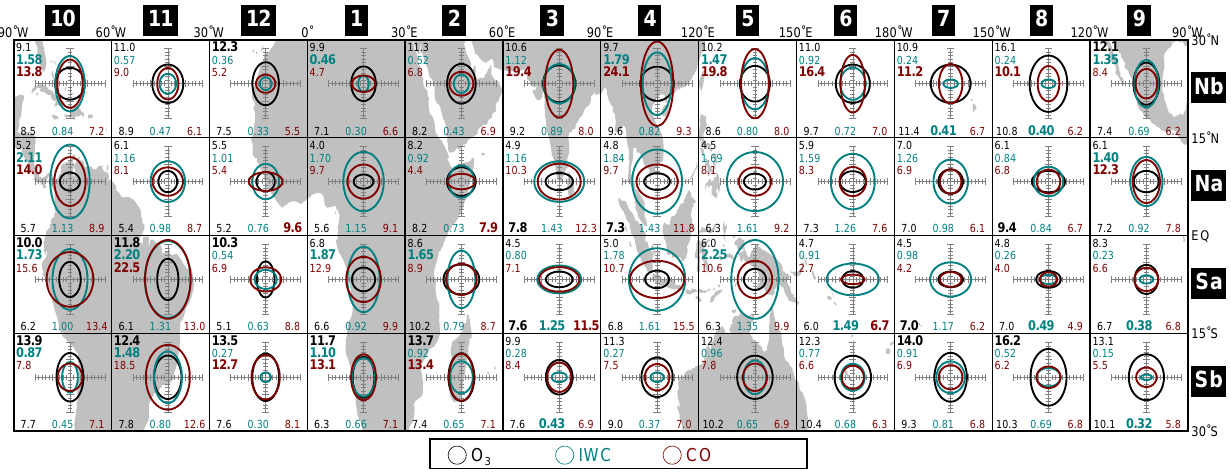
Fig. 8. Map summarizing the S (height of each ellipse) and V (width of each ellipse) statistics for O 3 (black), IWC (cyan) and CO (red). The ‘crosshairs’ give the scale, with major ticks at 10 and 20ppbv for O 3 and CO and 1 and 2mgm − 3 for IWC. Corresponding (color coded) values of S are shown in the top left of each panel (large/bold type indicates ‘distinctly seasonal’ cases where S > 1 . 5 V ), with V shown along the bottom edge (where large/bold type indicates ‘mostly interannual’ cases having V > 1 . 5 S ).